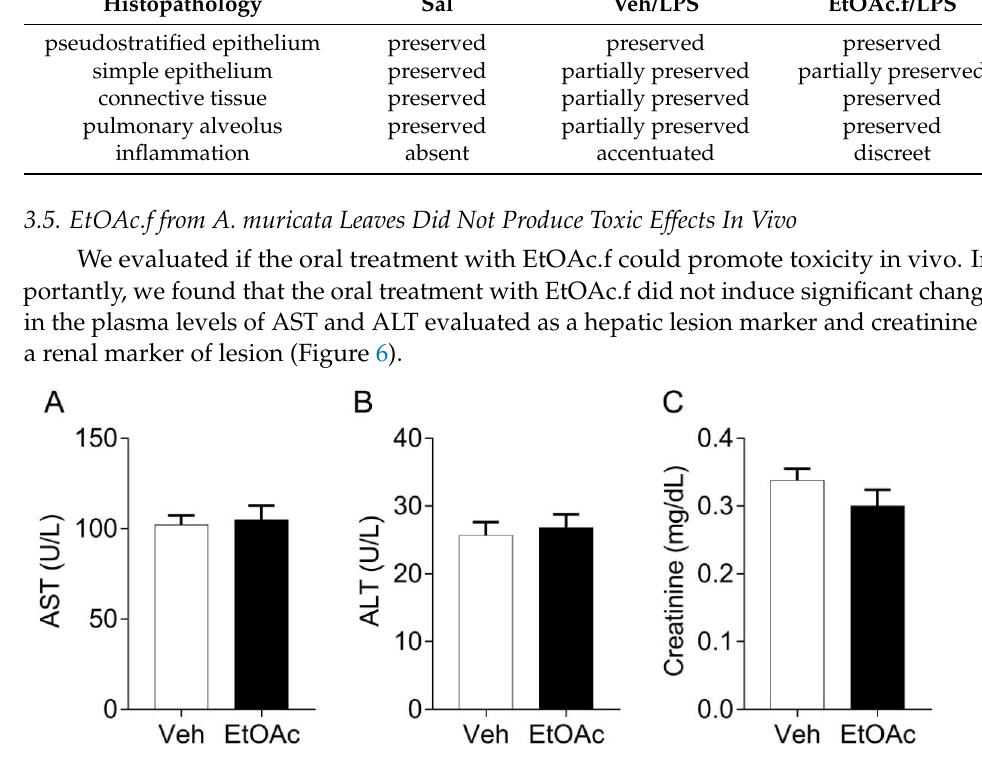
Histopathology pseudostratified epithelium